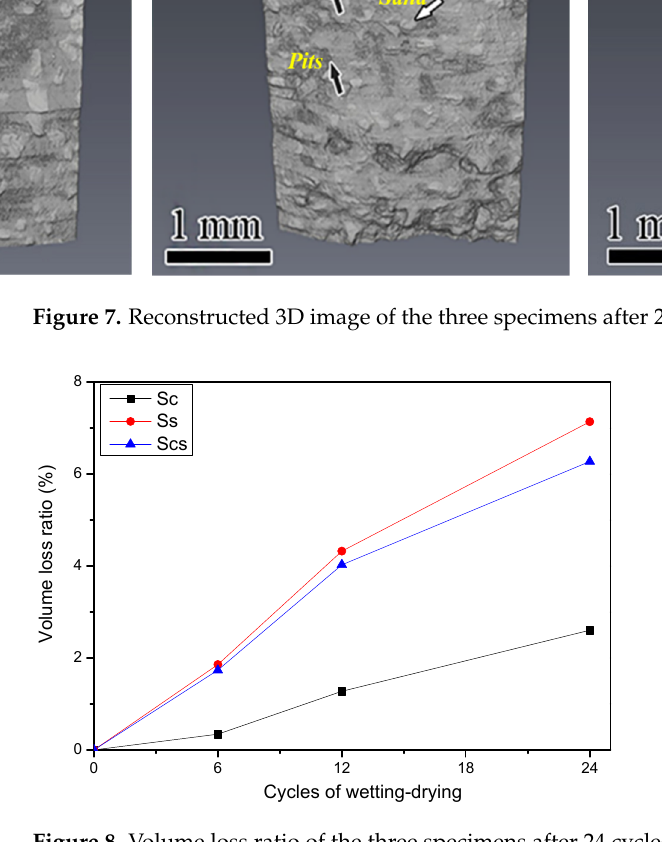
Figure 8. Volume loss ratio of the three specimens after 24